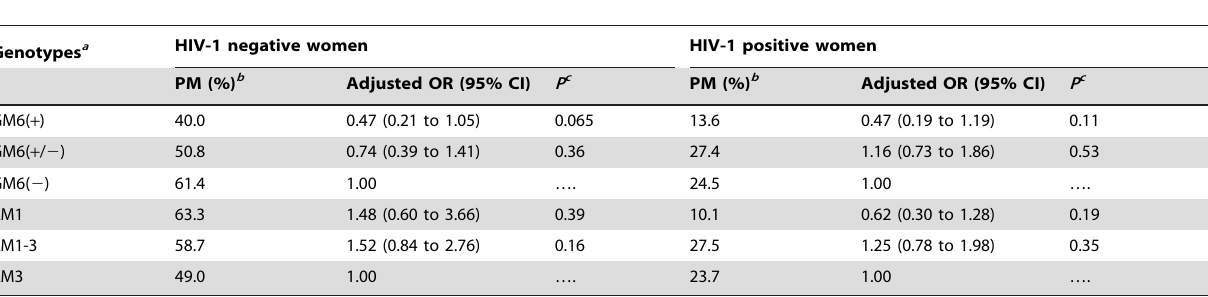
Table 3. Effect of individual GM6 and KM genotypes on the risk for PM in HIV-1 negative and positive women.